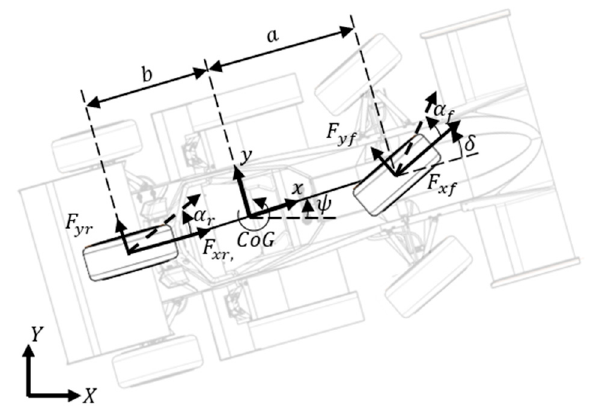
Figure 3. 3-DOF rigid vehicle model single track.